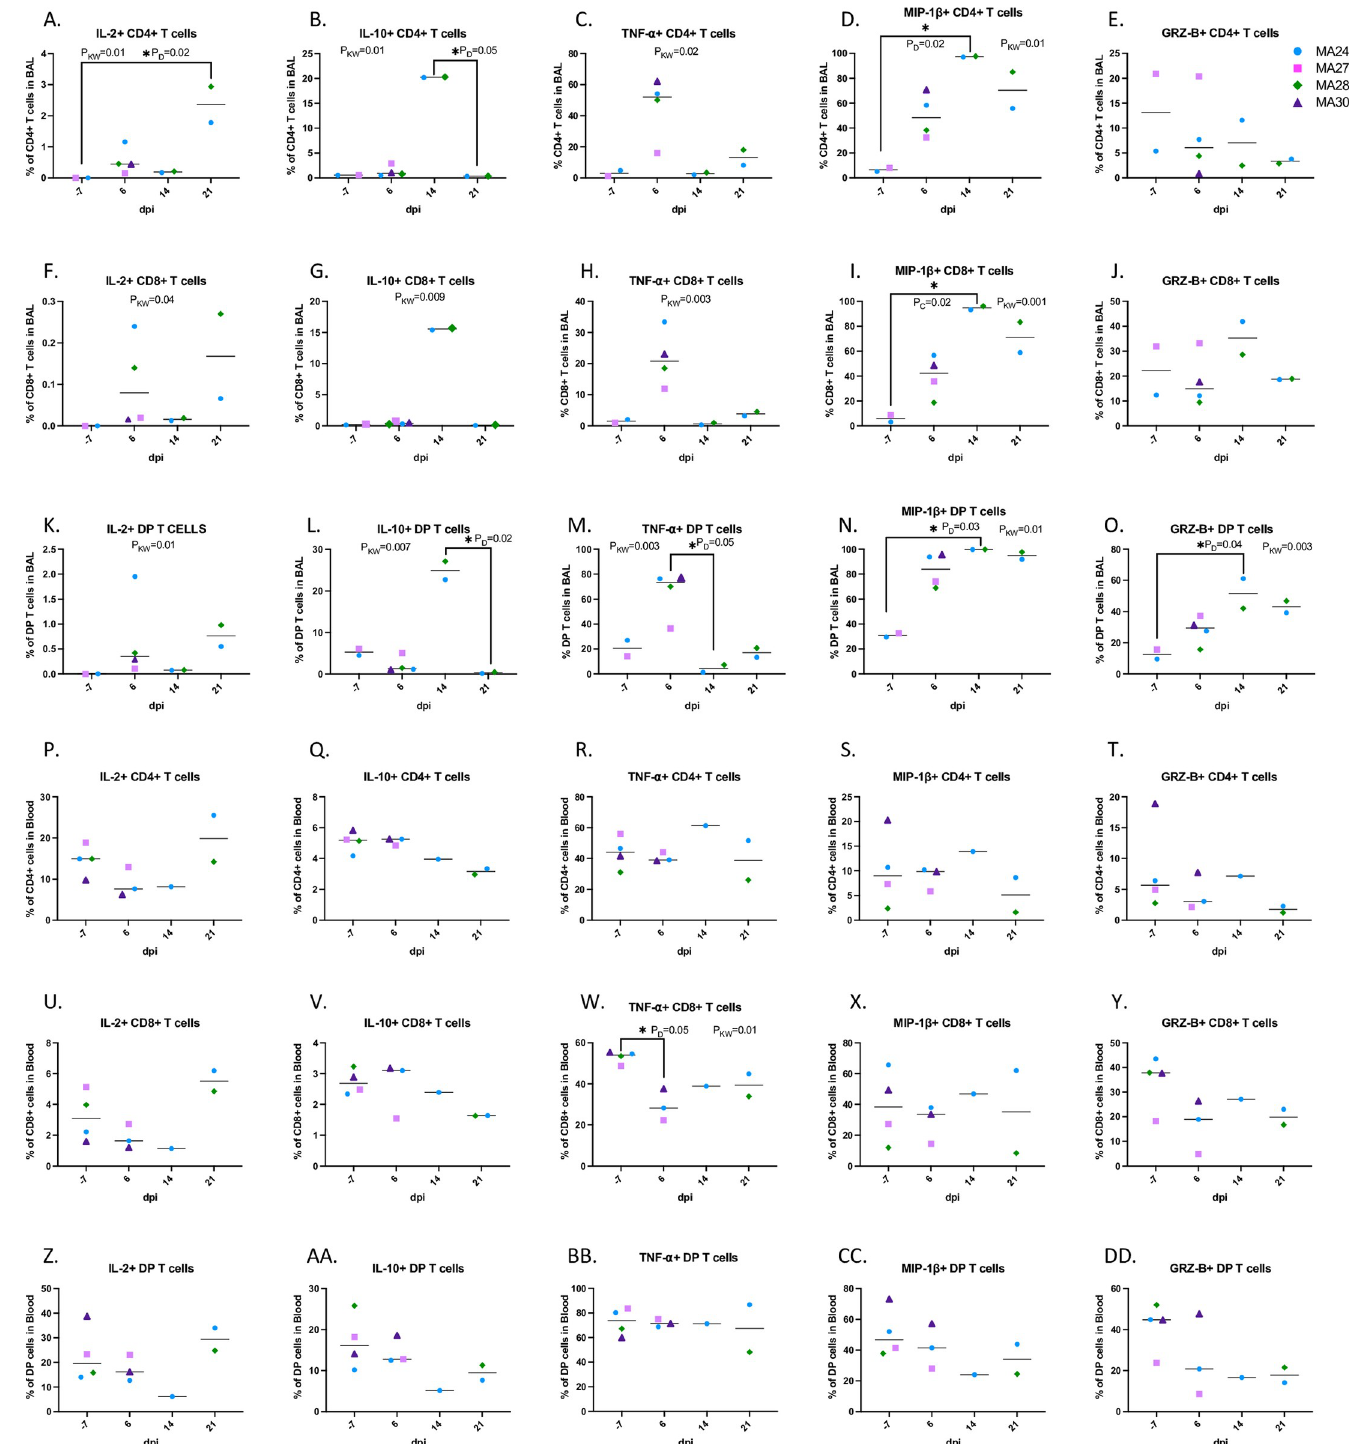
Fig 8. Changes in T cell cytokine expression in the lung (A-O) and blood (P-DD). PMA/ionomycin stimulated CD4+ T cells (BAL: A-E, Blood: P-T), CD8+ T cells (BAL: F-J, Blood: U-Y), and CD4+ CD8+ (DP) T cells (BAL: K-O, Blood: Z-DD). Bars represent median. Kruskal-Wallis comparison of overall means (P KW ) and Dunn’s Multiple comparisons (designated by line, P D ) tests used to determine significance. P values � 0.05 reported. Panels A-O. Baseline (-7): n = 2, Day 6: n = 4, Day 14: n = 2, Day 21: n = 2. Panels P-DD. Baseline (-7): n = 4, Day 6: n = 3, Day 14: n = 1, Day 21: n = 2.